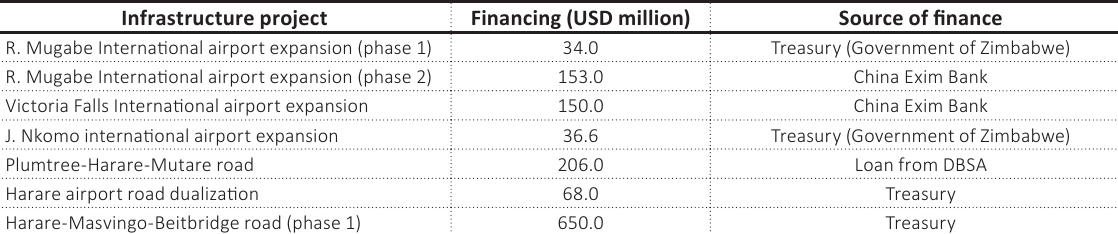
Table 2. Transport infrastructure projects